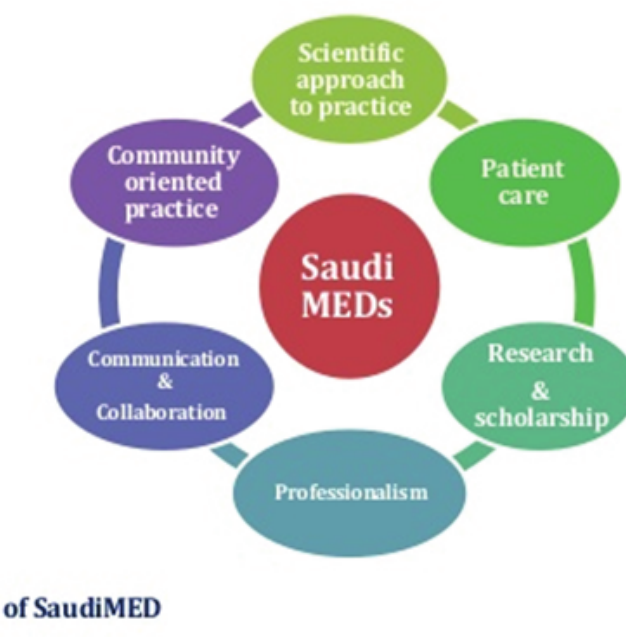
Figure 1: Example of National Competency Framework in the region (SaudiMEDs)